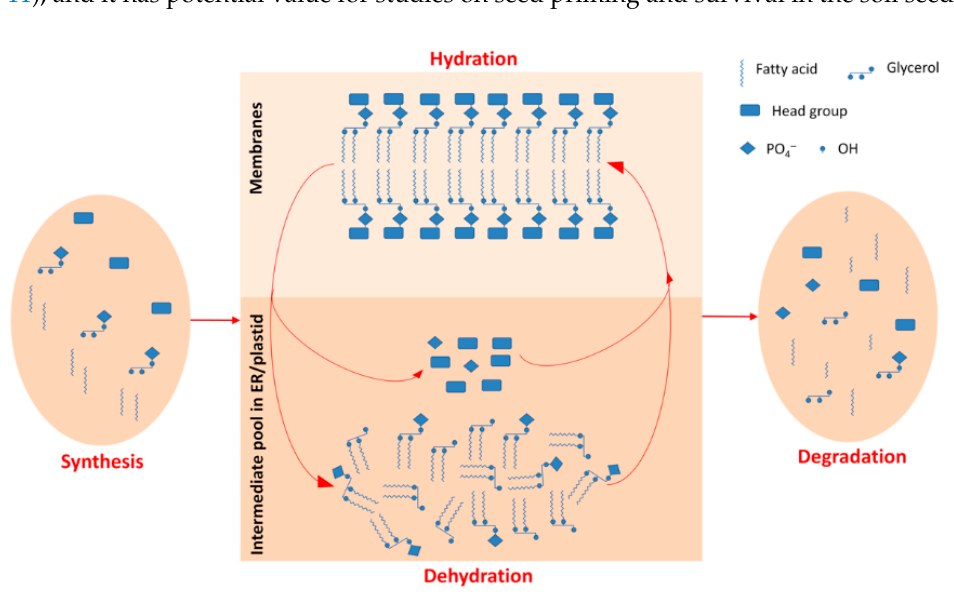
Figure 11. Working model for a metabolic cycle in glycerolipids during hydration–dehydration cycles. The metabolic cycles in glycerolipids are just between intermediate pool in endoplasmic reticulum/plastid and final products of glycerolipids in membranes and not involved in synthesis or degradation. The seeds use the metabolic cycles to respond to hydration–dehydration